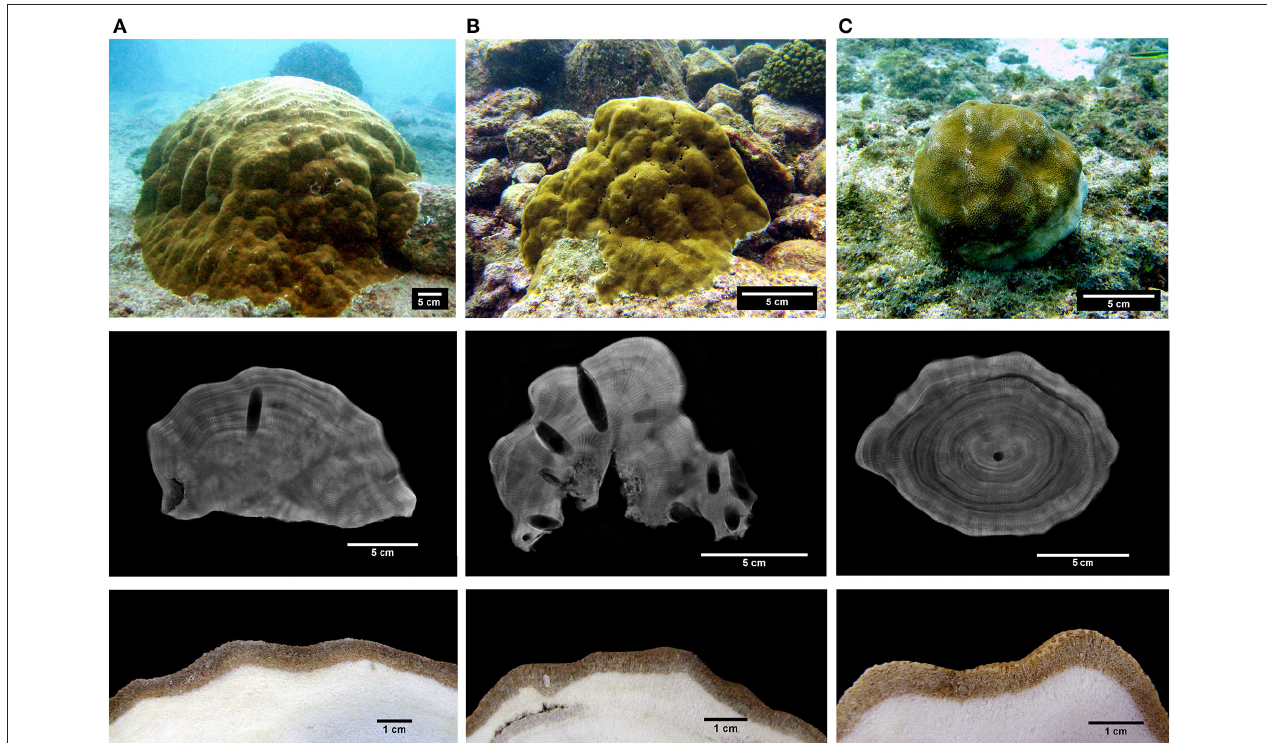
FIGURE 2 | Different morphotypes of Porites lobata in situ , under X-radiography and photograhps of coral slices displaying tissue thickness. (A) Massive, (B) Columnar, and (C) Corallith (free-living).